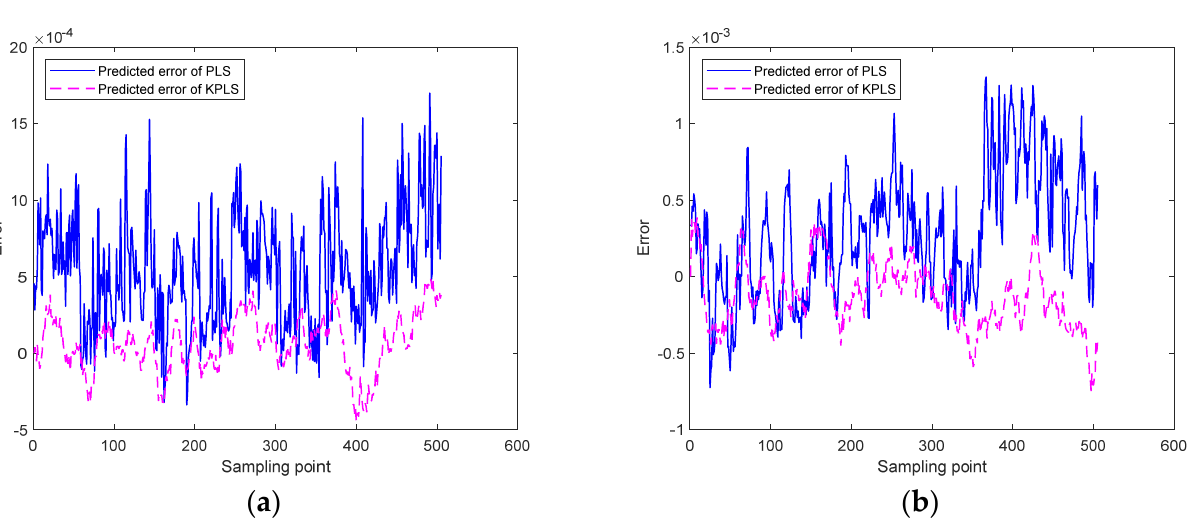
Figure 7. Mach number prediction errors of the mean-value PLS and mean-value KPLS models. ( a ) Mode 1. ( b ) Mode 2.